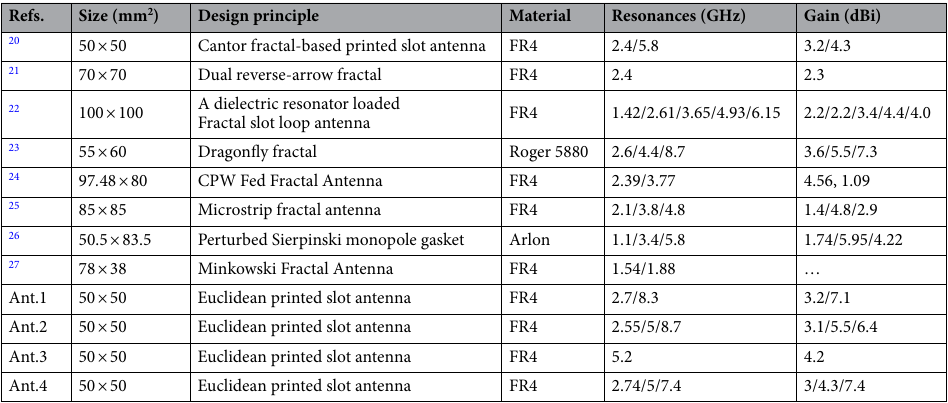
Table 5. Comparison with other testified antennas in the literature.